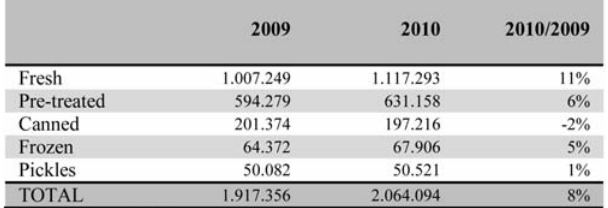
Table 4. Top 10 Domestic purchases of fresh fruit (in kg per household)